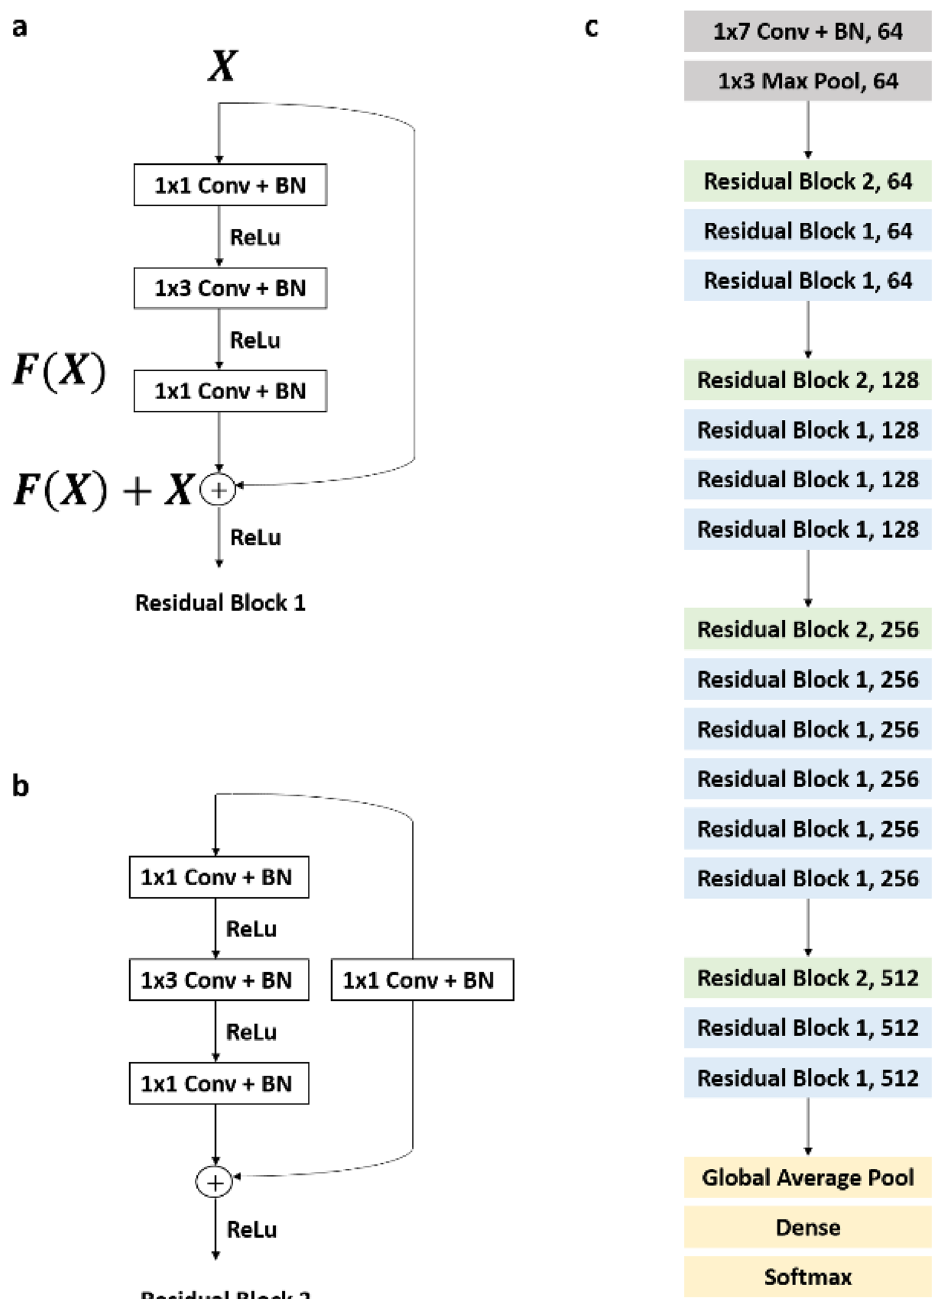
Figure 2. Schematic diagram of residual block. ( a ) Residual block when previous layer and present layer are same dimensions. ( b ) Residual block when previous layer and present layer are different dimensions. ( c ) Resnet 50